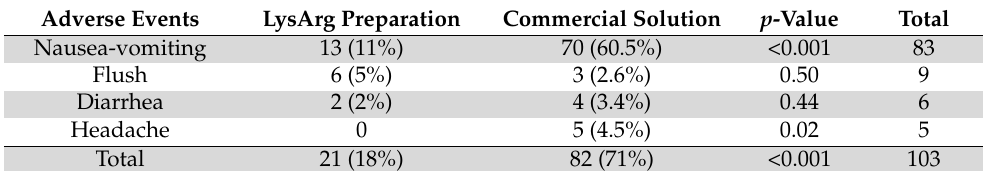
Table 4. Individual adverse event occurring in patients per